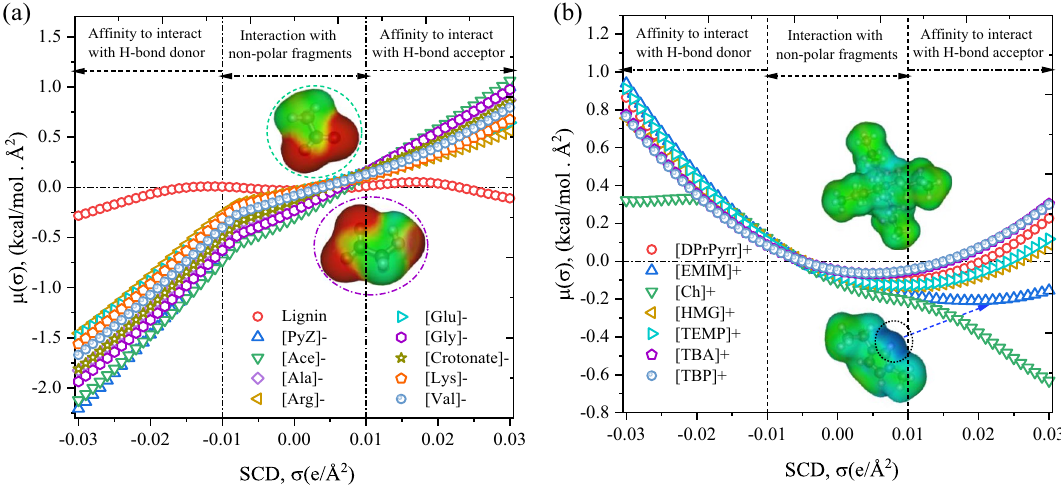
Figure 4. COSMO-RS predicted sigma potential of ( a ) lignin and anions, and ( b ) cations of ILs at 363.15 K. COSMOTherm version 19.0.1 was used to calculate the sigma potentials (https:// www. 3ds. com/ produ cts- servi ces/ biovia/ produ cts/ molec ular- model ing- simul ation/ solva tion- chemi stry/ biovia- cosmo